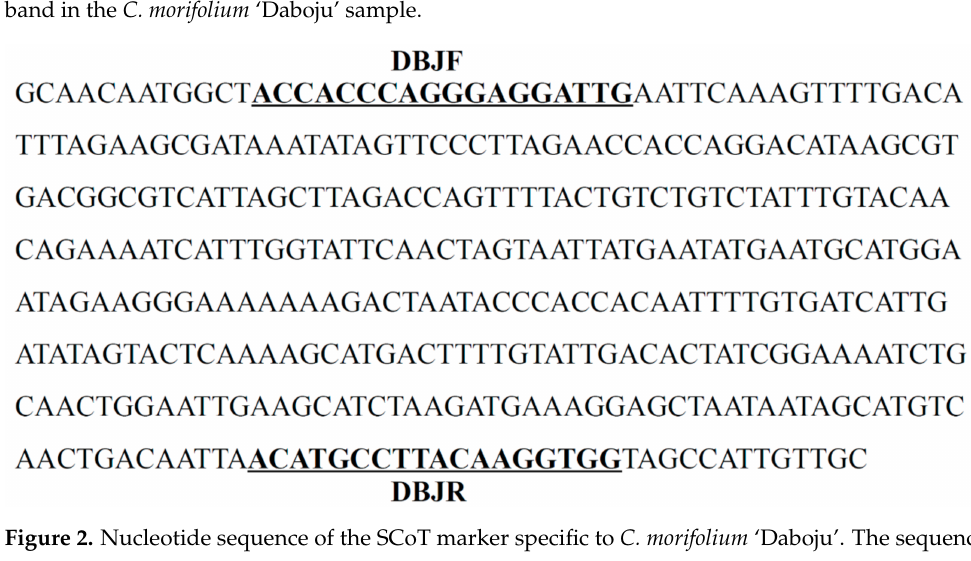
Figure 1. SCoT36 profiles of the 21 different C. morifolium cultivars (lanes 1–21). Lane M: Trans2K DNA markers with specified amplified product lengths (bp). Arrowheads represent specific amplified band in the C. morifolium ‘Daboju’ sample.